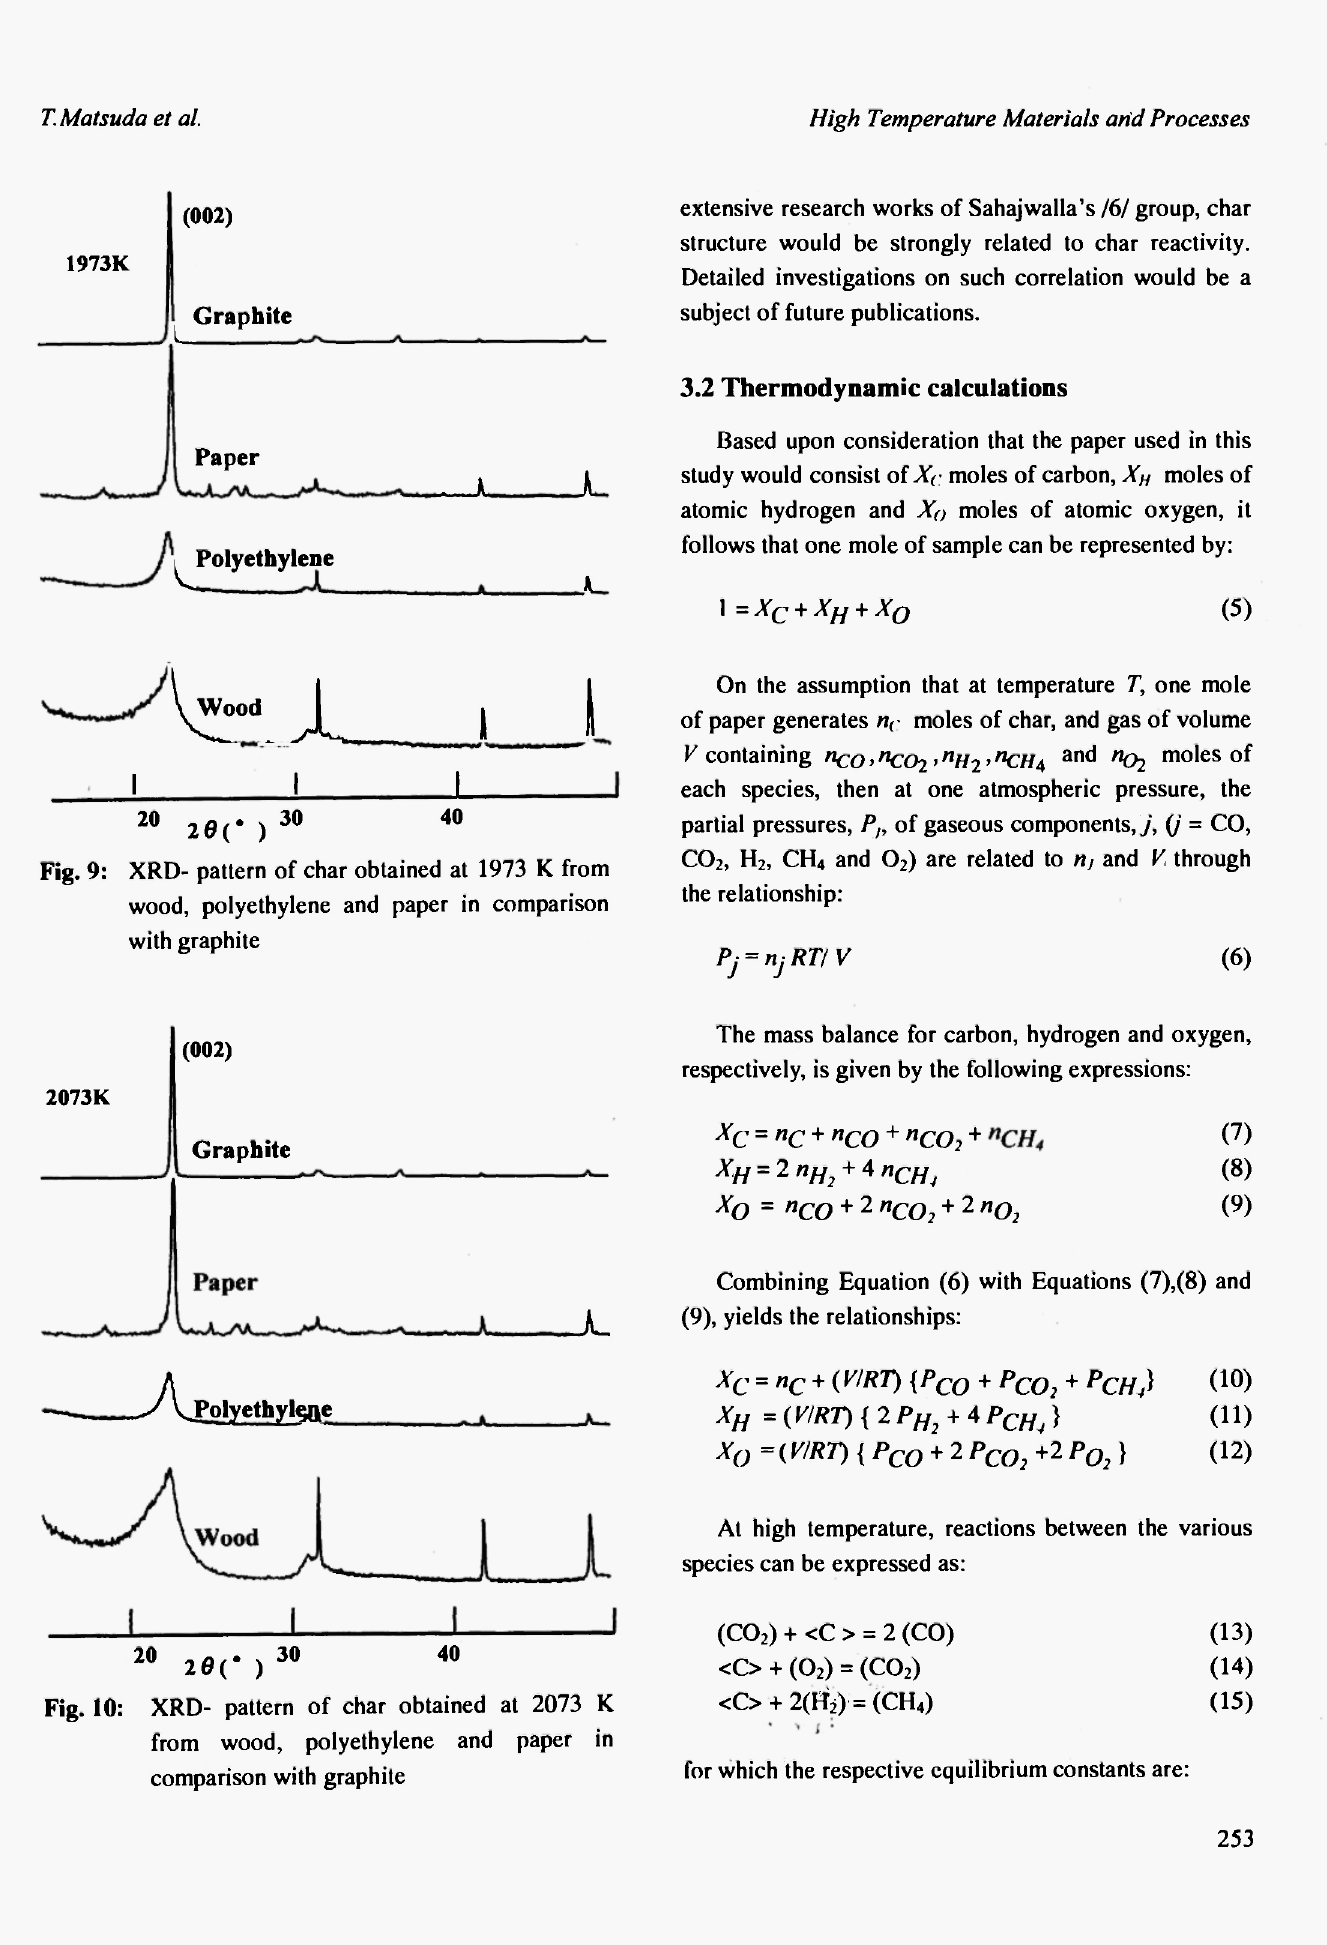
Fig. 10: XRD- pattern of char obtained at 2073 Κ from